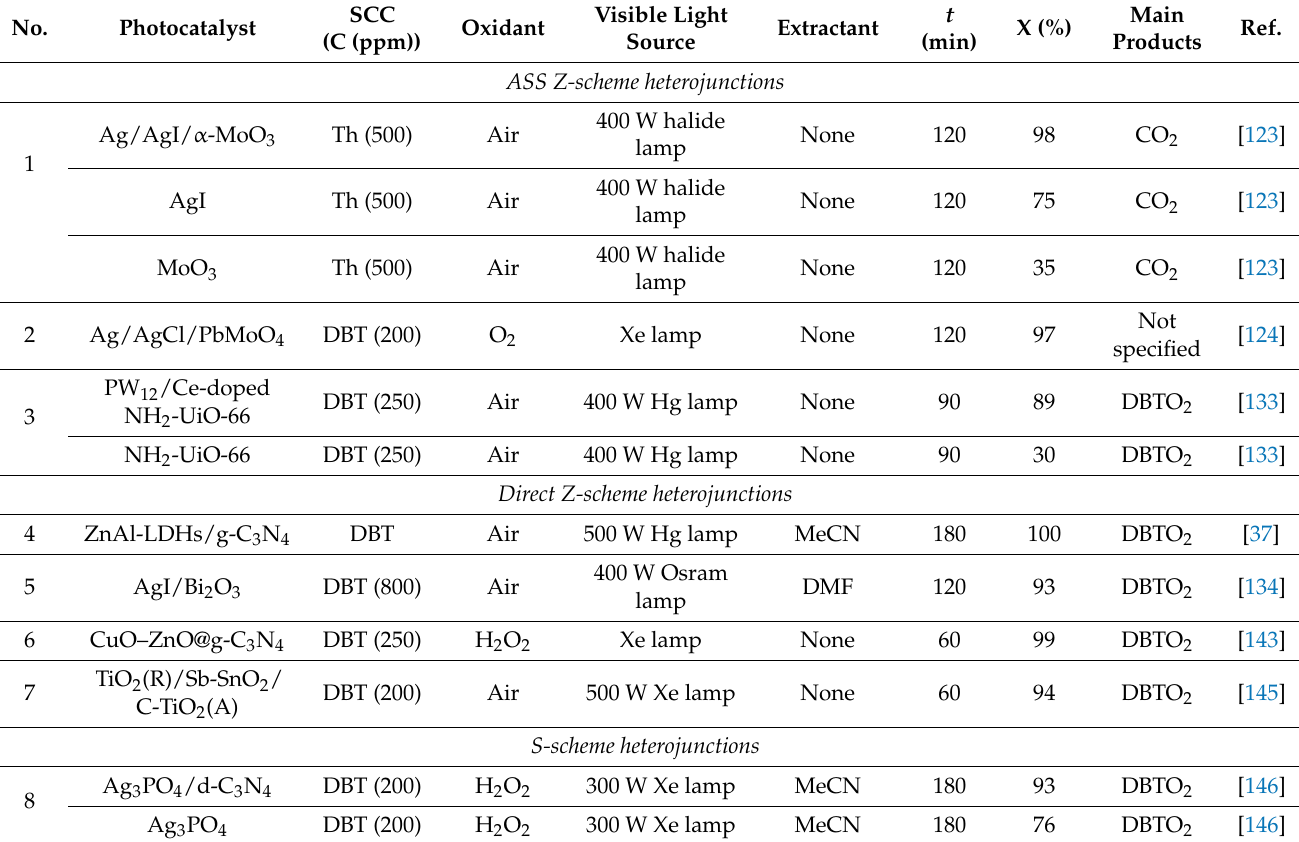
Table 4. Activity of ASS and direct Z-scheme as well S-scheme heterojunctions in